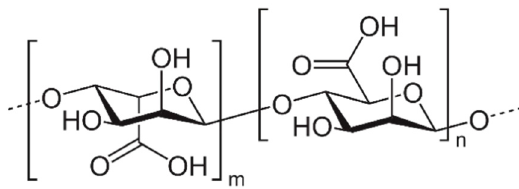
Figure 5. Chemical structure of alginate.